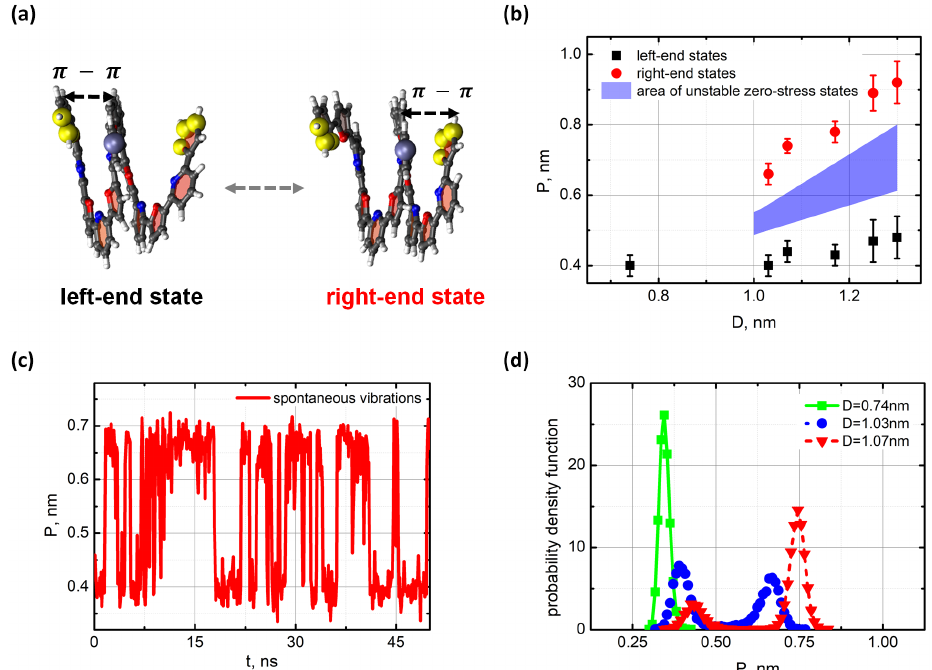
Figure 4. Bistability of the oligo-PF-7 spring. ( a ) The left- and the right-end states of the oligo-PF-7 (yellow spheres show fixed atomic groups at the ends of the spring); ( b ) State diagram of the oligo- PF-7 states with increasing the end-to-end distance D ( c ) Spontaneous vibration of the turn between the ends of the oligo-PF-7 spring at D = 1.03nm ( P is the distance between the turn and the left end of the spring); ( d ) Evolution of the probability distribution density for visiting the left-end and the right-end states at different distances D ; almost symmetric distribution is seen at D =